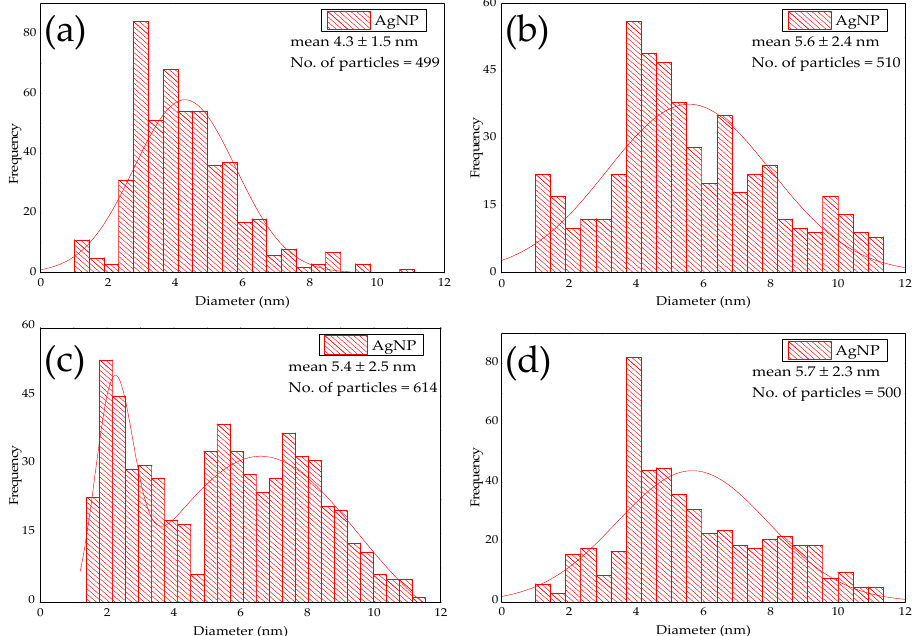
Figure 5. Mean particle size distribution of AgNPs produced by: ( a ) WT-1.250 mM; ( b ) WT-0.625 mM; ( c ) CWD-1.250 mM; and ( d ) CWD-0.625 mM.